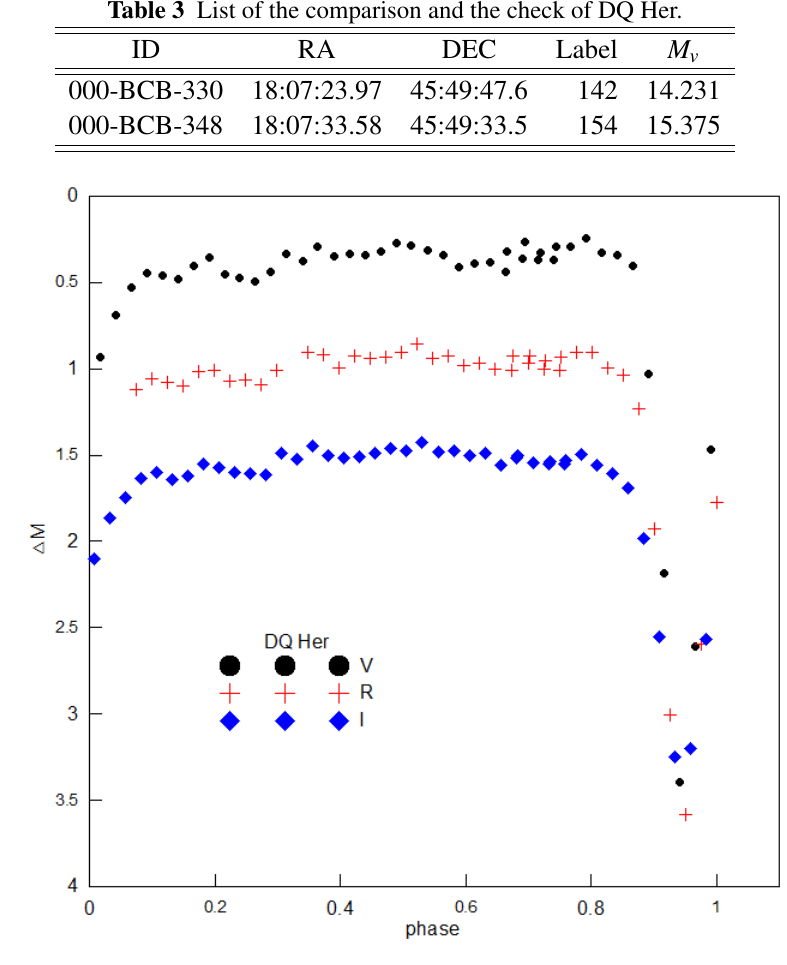
Fig. 5 the observed VRI phase diagrams of DQ HER folded with 4.6 day